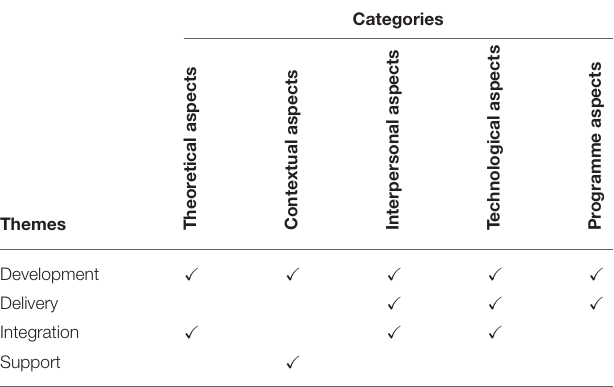
TABLE 4 | Summary of categories contributing to